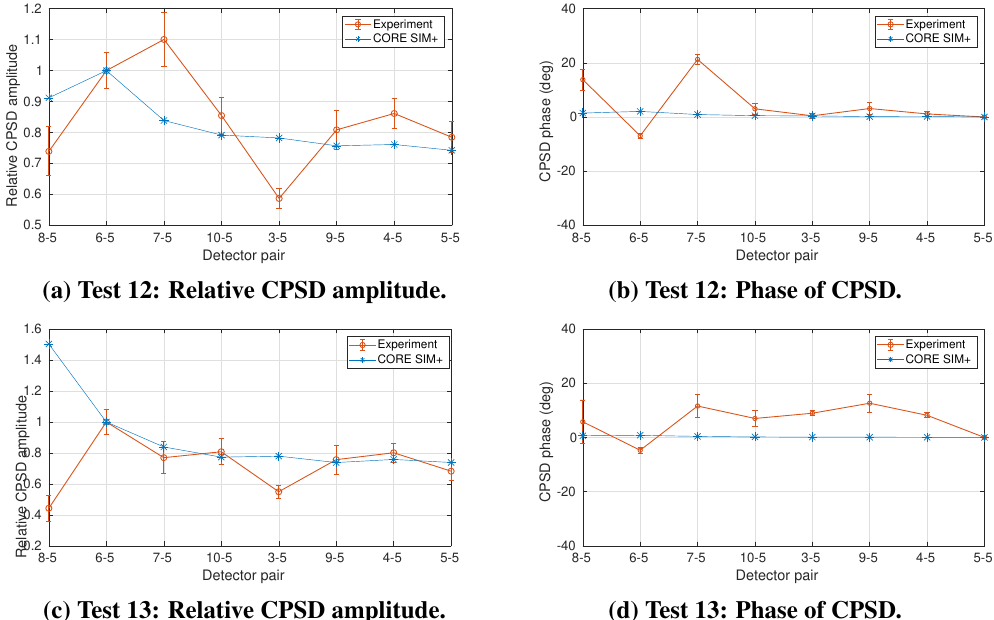
Figure 5: Comparison of the computational results with experimental